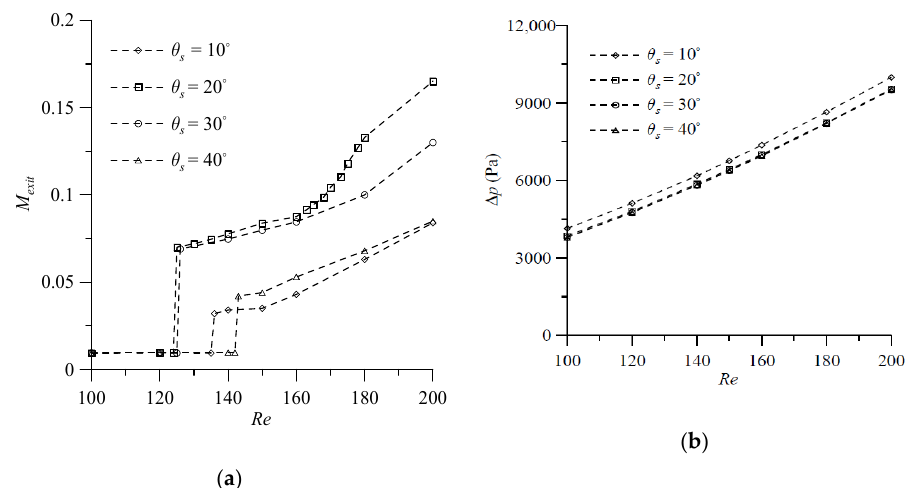
Figure 11. E ff ect of angle of attack θ s on ( a ) the degree of mixing, and ( b ) the pressure drop in the θ on ( a ) the degree of mixing, and ( b ) the pressure drop in the Figure 11. Effect of angle of attack s mixers with d = 3 H , h = 0.75 H , t = 0.25 H and w d = 0.25 H for various Reynolds numbers. 0.25 w H = mixers with d = 3 H , h = 0.75 H , t = 0.25 H and for various Reynolds numbers. d